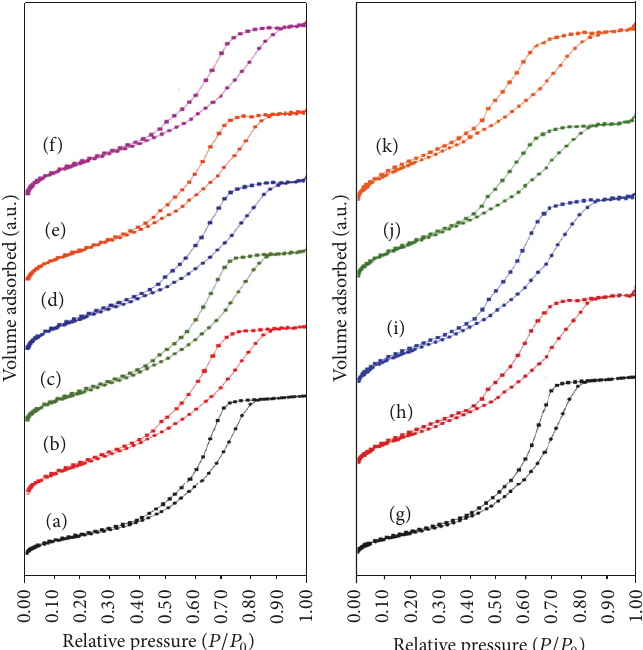
Figure 5: N 2 adsorption-desorption isotherms of the silica-based materials: (a) SiO 2 , (b) SiO 2 @ imineSA, (c) SiO 2 @ imineSB, (d) SiO 2 @ imineSA-Pd-II, (e) SiO 2 @ imineSB-Pd-II, (f) SiO 2 @ imineSA-Pd-I, (g) SiO 2 , (h) SiO 2 @ imineNA, (i) SiO 2 @ imineNB, (j) SiO 2 @ imineNA- Pd-II, and (k) SiO 2 @